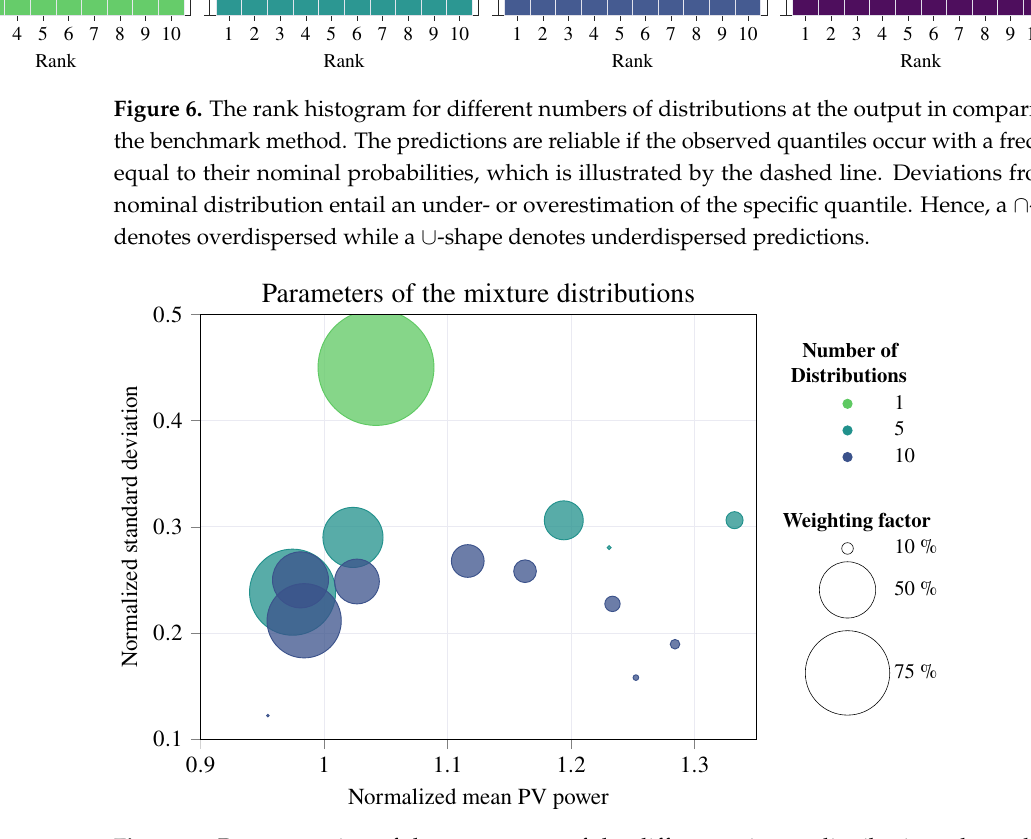
Figure 7. Representation of the parameters of the different mixture distributions depending on their number in the model output. The size of the markers reflects their respective weighting factor in the mixture model. In order to enable comparability for varying power levels, both the standard deviation and the mean of the distributions were normalized by dividing the values with the respective measured PV